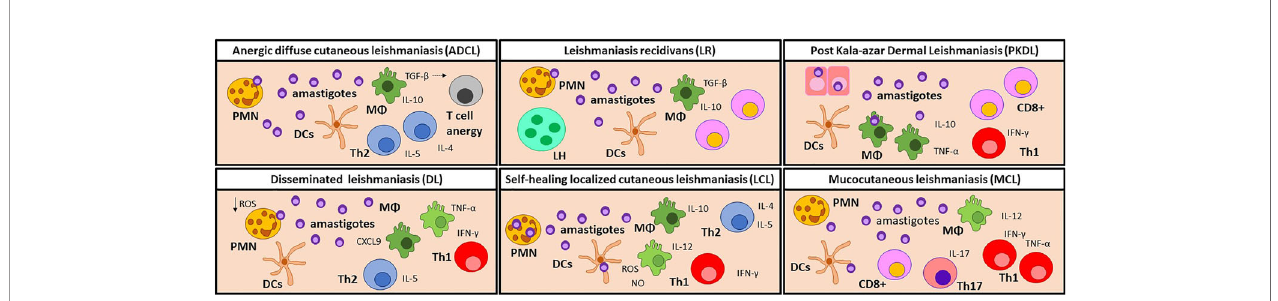
FIGURE 2 | Immune cell pro fi les in the skin lesion of CL and PKDL patients. Anergic diffuse cutaneous leishmaniasis (ADCL) lesions are developed due to a lack of a Th1 response. Parasites can interact directly with macrophages which, even when abundant, are polarized towards an M2 pro fi le and produce high levels of TGF- b . Consequently, T cells are activated towards IL-4, IL-5, and IL-10-producer Th2 cells. In this environment, T cells become anergic, leading to chronic disease. It is noteworthy that this manifestation is particularly common in immunosuppressed patients. Disseminated leishmaniasis (DL) patients show a temporary impairment of the early T cell response, which allows for dissemination of the parasite. Later, CXCL9 attracts T-cells to the lesion site, causing a lack of systemic Th1 response. In the lesion, IL-10, iNOS, TNF- a , and IFN- g are found in similar levels as LCL lesions. In self-healing localized cutaneous leishmaniasis (LCL), phagocytes are the fi rst responders against infection by producing ROS and NO to destroy the parasites, but can also become permissive hosts for amastigotes. A Th1 response, characterized by IL-12 and IFN- g , is necessary for the control of the disease while the Th2 immune response promotes tissue repair, leading to the self-healing of the lesion. In rare occasions, LCL can relapse as Leishmaniasis recidivans (LR), but the trigger stimulus is still unknown. LR is characterized by TGF- b and IL-10 production, as well as an increased ratio of CD8+ vs. CD4+ T cells. LR lesions also show a granulomatous in fi ltrate containing lymphohistiocytic and multinucleated giant cells. Post Kala-azar Dermal Leishmaniasis (PKDL) develops when the cellular response is reactivated after drug treatment. The remaining parasites in the skin elicit an increased in fl ammatory response and the development of dermal lesions. An increased proportion of CD8+ T cells over CD4+T cells is often observed, but the role of CD8 T cells is still unclear. Mucocutaneous Leishmaniasis (MCL) lesions are characterized by a chronic and hyperactive in fl ammatory immune response. IFN- g and TNF- a producing Th1 cells and cytotoxic CD8+ cells are predominant leading to tissue destruction. The high numbers of Th17 and polymorphonuclear neutrophils (PMN) contribute to exacerbated in fl ammation, while the low levels of IL-10 detected are related to the poor control of in fl ammation. Manifestations with a mixed immune pro fi le lead to a moderate pathology, while a hyperpolarized response results in a severe disease. M F , Macrophages; DCs, dendritic cells; PMN, Neutrophils; Th, T helper cells; LH, lymphohistiocytic and multinucleated giant cells; PKDL, Post Kala-azar Dermal